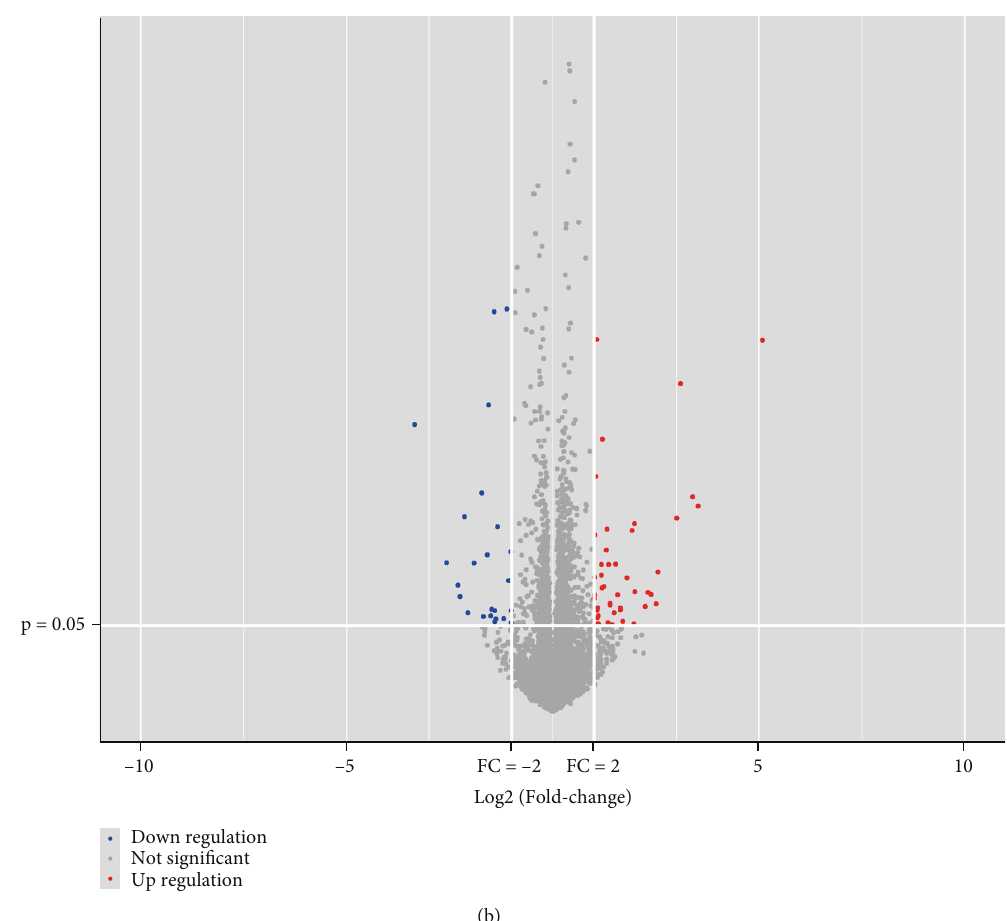
Figure 3: mRNA DEGs analysis. (a) Heat map and (b) volcano map illustrations of di ff erential